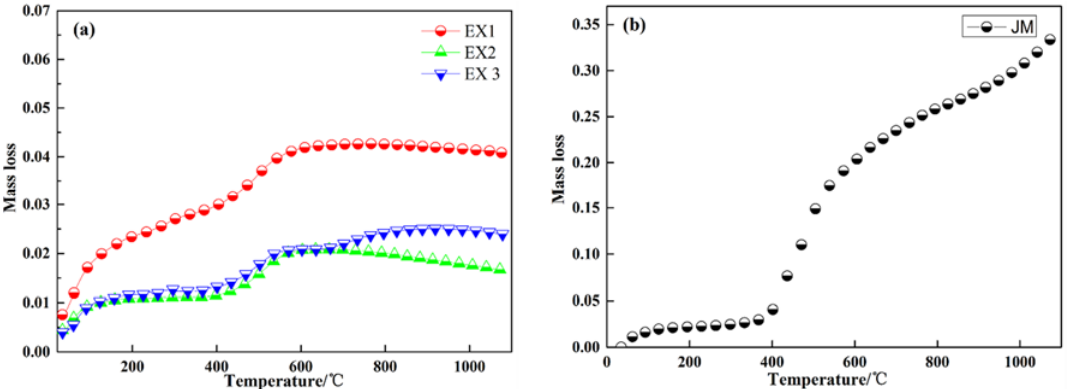
Figure 3. Mass loss for iron ore and coal (JM) under an Ar atmosphere: ( a ) the mass loss of different particle sizes of EX iron ore, ( b ) the mass loss of coal.